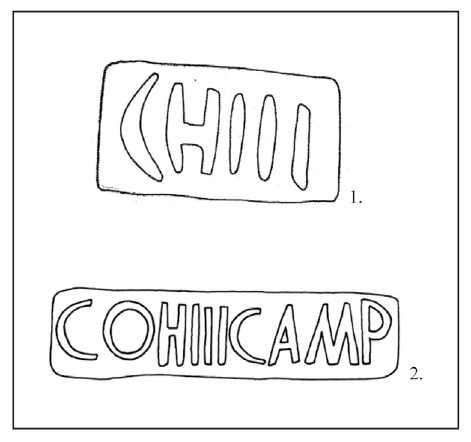
Figure 2. 1: Tile-stamp from Porolissum (after Tóth, 1978); 2: Tile-stamp of coh III Campestris from Viminacium (after Gudea, 2001).